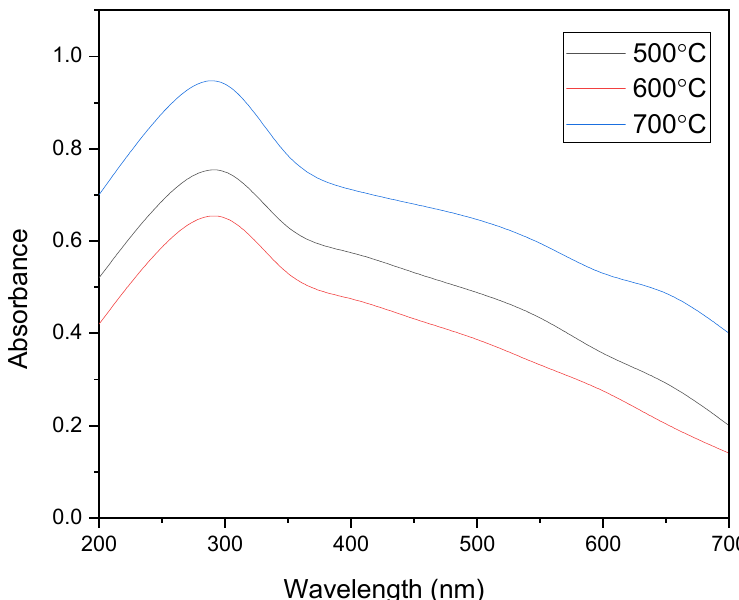
Figure 3. UV absorption profiles of pristine MgFe 2 O 4 nanoparticles calcined at different tempera- tures.